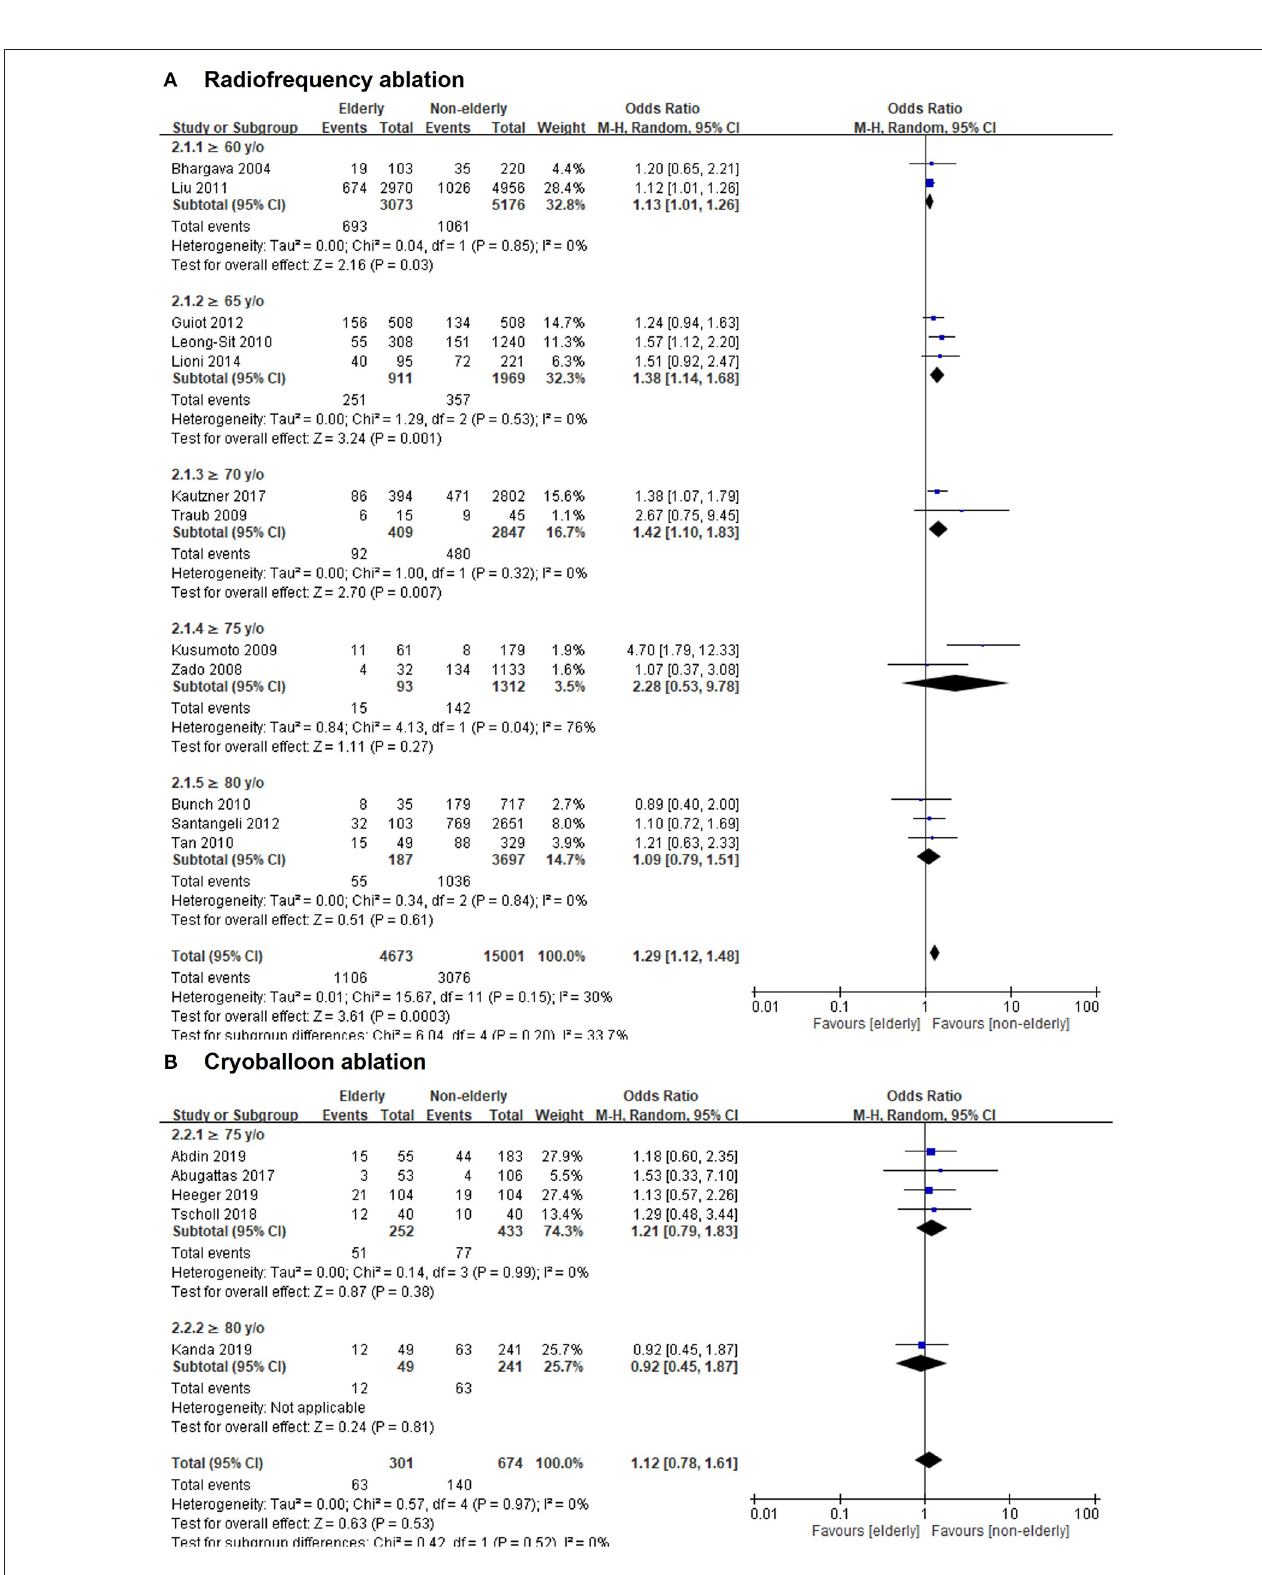
FIGURE 3 | Forest plots of the OR of recurrent AF or ATA after radiofrequency (RF) ablation (A) or cryoballoon ablation (B) between elderly and non-elderly groups from 17 studies with different age stratification.